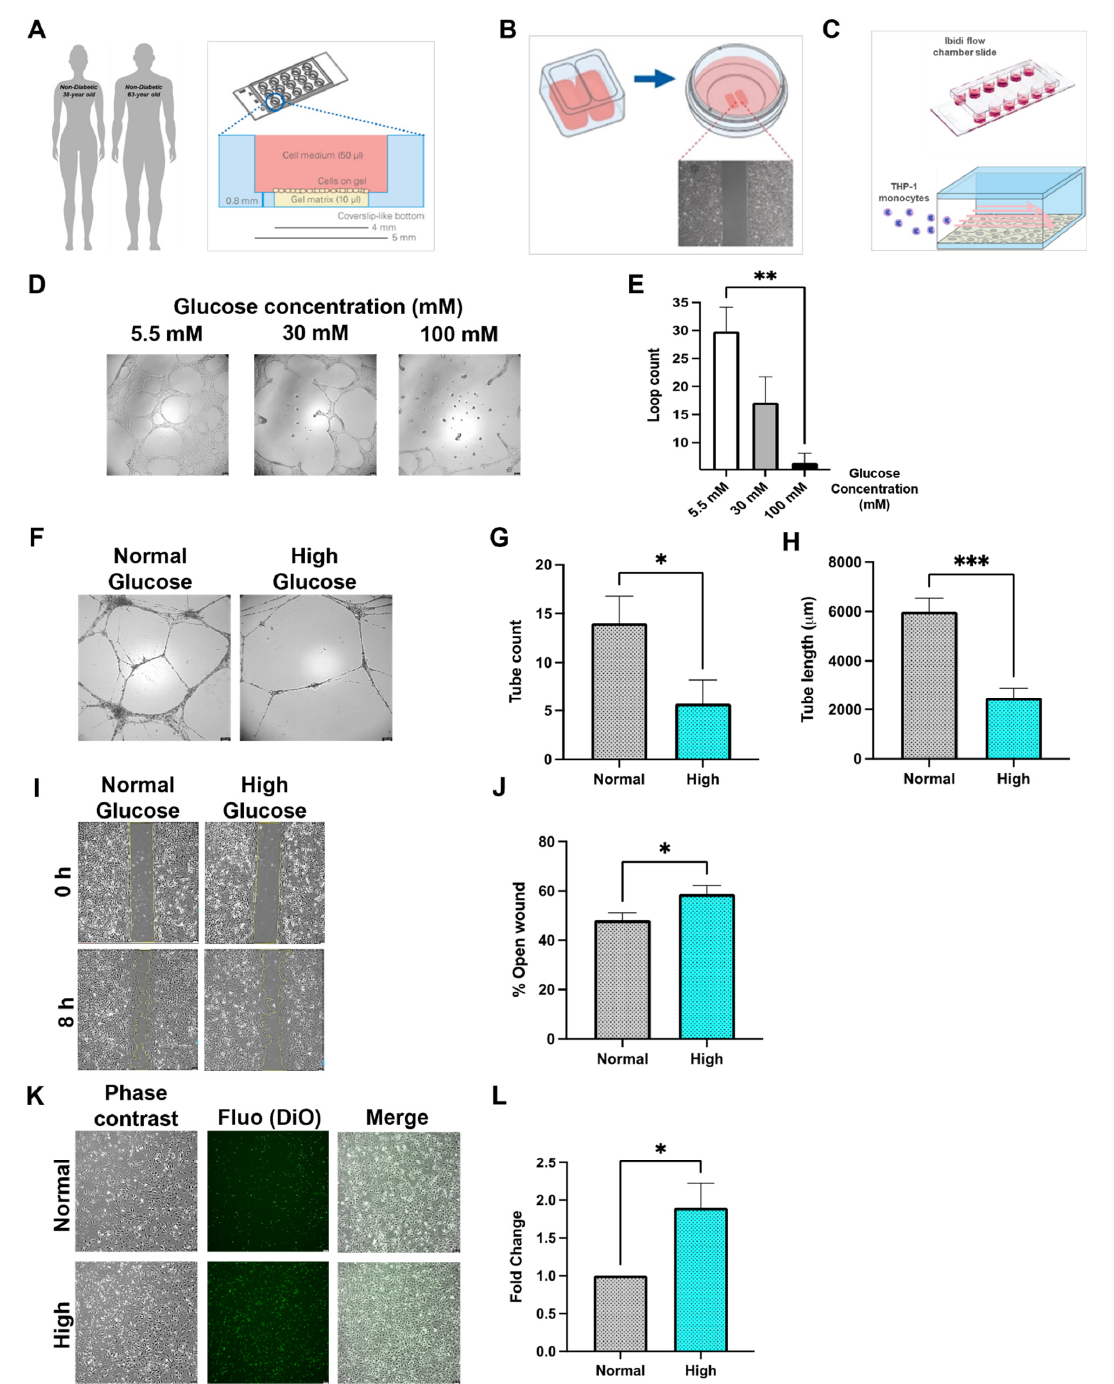
Figure 1. Characterization of MCMEC and HCMEC behaviour in normal and high glucose Sche- matic representation of the angiogenesis ( A ), wound healing ( B ) and flow chamber ( C ) techniques performed with Ibidi chambers. ( D , E ) Tube formation of MCMEC on Matrigel at different glucose concentration (mM). Bright field images and analysis of total loop count. ( F – H ) Tube formation of HCMEC on Matrigel, phase contrast images and analysis of tube formation parameters of HCMEC on Matrigel in normal (5.5 mM) or high (30 mM) glucose. ( I , J ) Examples and quantification of